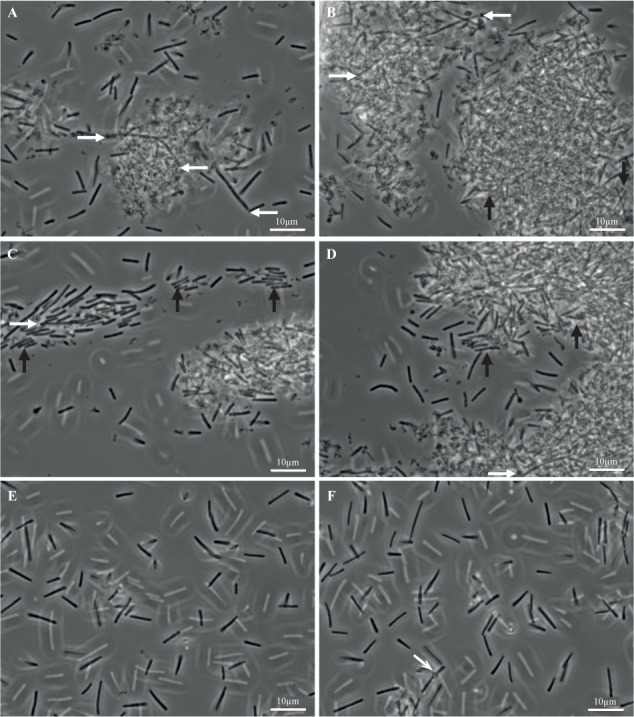
Biofilm and planktonic cells of strain 630Δerm. Biofilms (A–D) and planktonic cultures (E,F) of strain 630Δerm were grown in parallel in TYt medium, respectively, for 48 h in 24-well polystyrene micro-titer plates and for 24 h in Falcon tubes. After having been recovered, fixed and washed, biofilm and planktonic cells were observed by Transmitted Light Microscopy. Representative images are shown, with a white bar indicating the scale (10 μm). In biofilm (A–D), (i) elongated rods (∼20–30 μm) are shown by white horizontal arrows, and (ii) cells aligned side by side along the width and tightly packed into micro-aggregates are indicated by black vertical arrows. In a planktonic culture (F), a refracting spore is indicated by a gray oblique arrow.